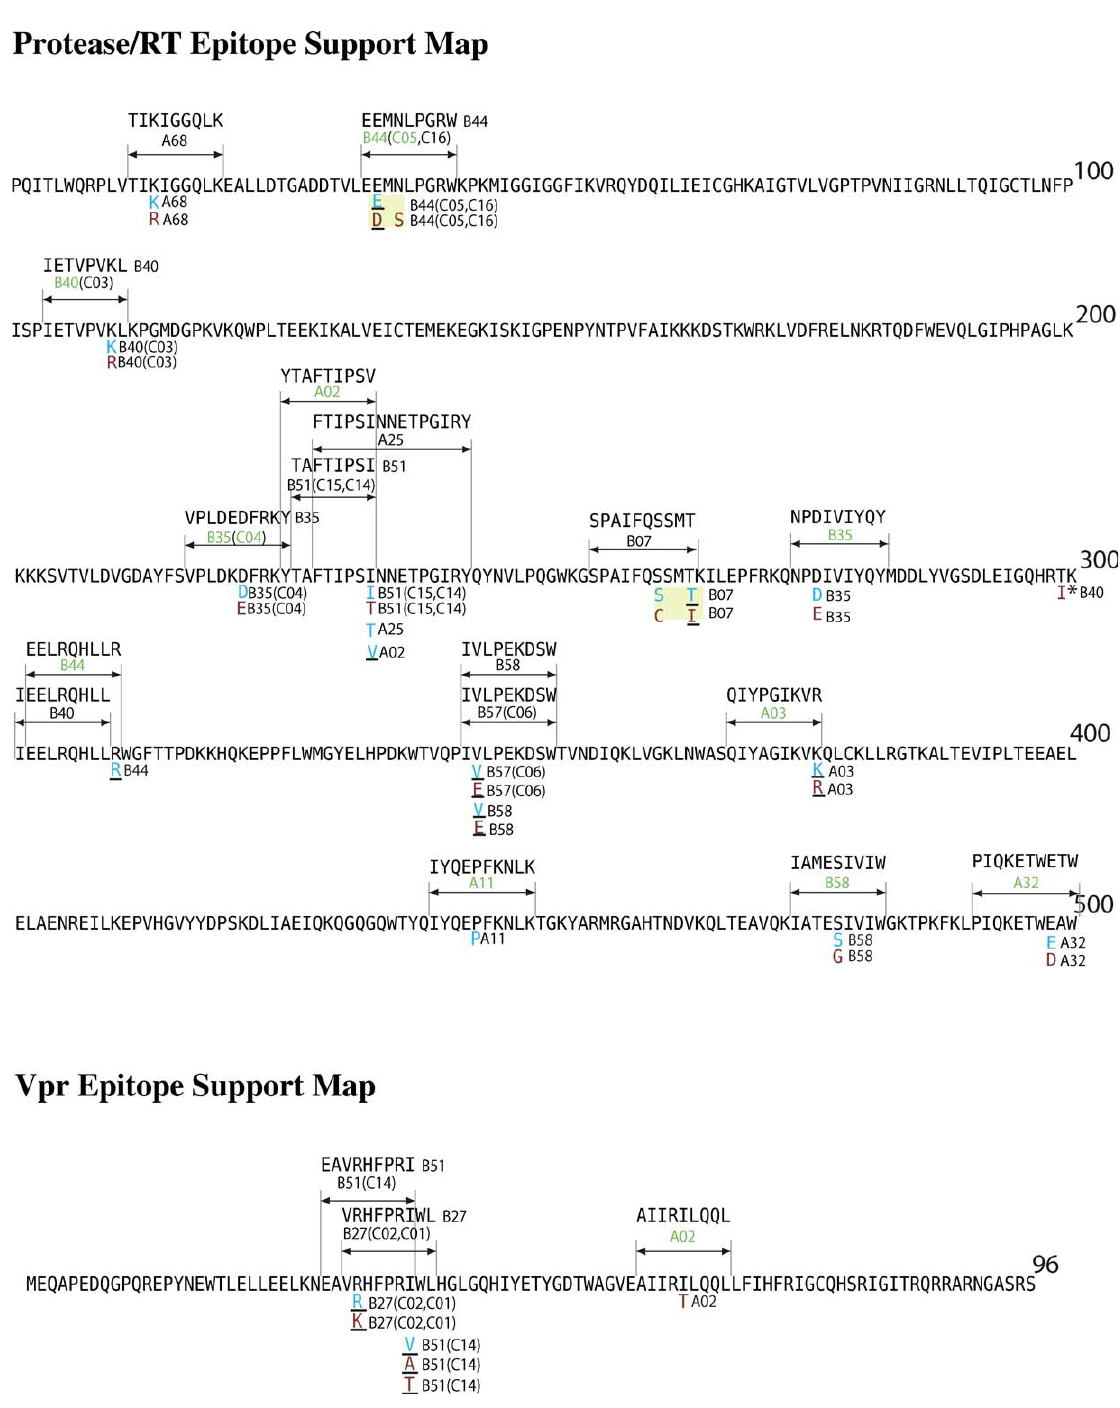
Figure 2. Epitope Support Maps: HLA-Associated Polymorphisms Mapping within or Directly Proximal to Published HLA-Restricted CTL Epitopes in Protease/Reverse Transcriptase and Vpr HLA-associated polymorphisms occurring within or directly proximal ( 6 3 aa) to published HLA-restricted CTL epitopes in protease/RT and Vpr are shown. Polymorphisms associated with the same HLA allele(s) occurring within, or directly proximal to ( 6 3 aa) published HLA-restricted epitope boundaries are boxed together in yellow. The published epitope sequence (and associated HLA) is indicated above the epitope boundary arrow. If associations within the same epitope boundaries are ascribed to several linked HLA alleles, the HLA that is known to present the epitope is indicated next to it. Red ( ‘‘ escape ’’ ) amino acids indicate positive correlations (amino acids that are enriched in the presence of a specific HLA allele). Thus, ‘‘ escape ’’ (red) amino acids presumably reflect the escape variant specific for that HLA allele. Blue ( ‘‘ reversion ’’ ) amino acids indicate negative correlations, where the presence of a specific HLA allele is associated with the absence of a particular amino acid at a specific position—or, likewise, where the absence of the specific HLA allele is associated with the presence of this amino acid. Thus, ‘‘ reversion ’’ (blue) amino acids presumably reflect the immunologically susceptible form specific for that HLA allele, and the amino acid to which the sequence may revert upon transmission to an HLA- unmatched host. Underlined associations indicate potential HLA anchor residue sites. Proximal associations (within 6 3 aa of epitope boundaries) are marked with an asterisk (*). Associations additionally supported by functional IFN- c (ELISpot) data are indicated in green. doi:10.1371/journal.ppat.0030094.g002 PLoS Pathogens |